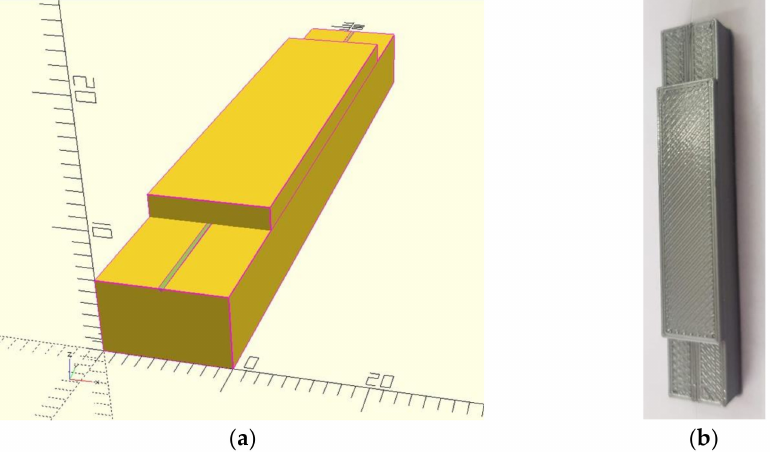
Figure 1. Three-dimensional model of the test bar with a v-groove intended for the optical fiber in a mm scale ( a ) and the bar printed for initial tests ( b